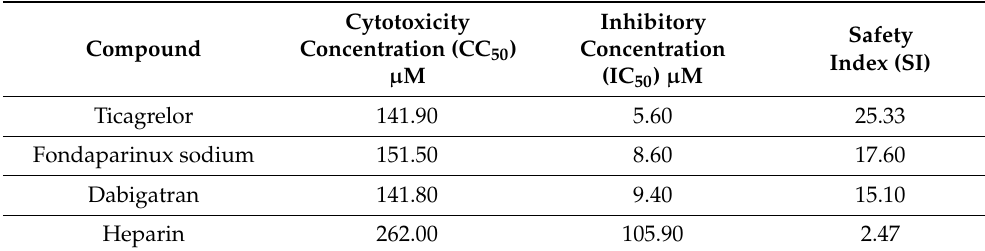
Table 5. Cytotoxicity and inhibitory effects of the screened anticoagulant drugs (ticagrelor, fonda- parinux sodium, dabigatran, and heparin) against SARS-CoV-2 reveal their safety indexes.